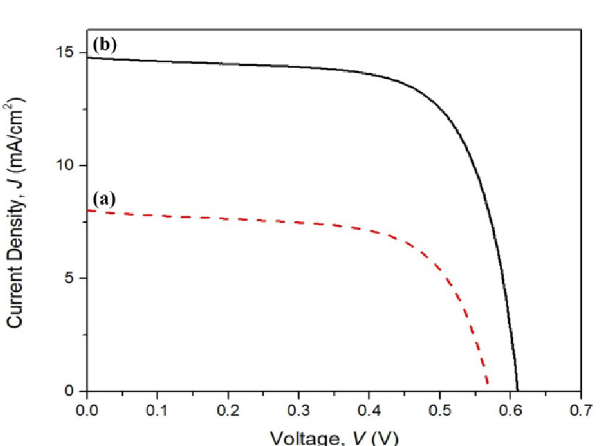
Fig 7. J–V curves of DSSCs under AM 1.5 condition (power density, Px = 100 mW/cm 2 ) with photoanode based on (a) mesoporous TiO 2 and (b) GO72–TiO 2